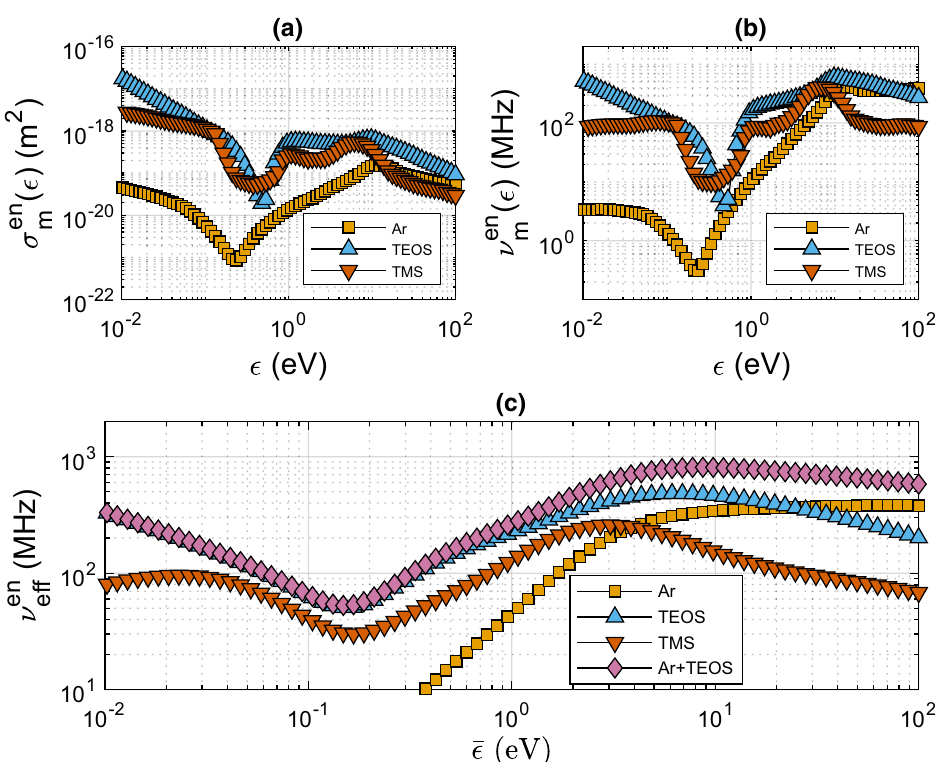
Fig. 5 Theoretical evaluation of electron-neutral momentum transfer collisions for different neutral gas species. The neutral gas species are denoted in the legend as argon (Ar, orange squares), tetraethylorthosilicate (TEOS, blue upward-facing triangles), and tetramethylsilane (TMS, red downward-facing triangles). a The momentum transfer cross section σ en is obtained from literature for argon 69 , TEOS 70,71 , and TMS 70,72,73 as a function of electron m energy ϵ . b The momentum transfer collision frequency ν en is calculated using Eq. (14) as a function of electron energy ϵ , using the neutral gas density m n = 1.75 × 10 21 m − 3 (for pressure p = 7.1 × 10 − 2 mbar) and the momentum transfer cross section. c The effective collision frequency ν en is calculated using eff Eq. (13) as a function of the electron mean energy (cid:1) ϵ . The total effective collision frequency (Ar + TEOS, purple diamonds) was calculated using the